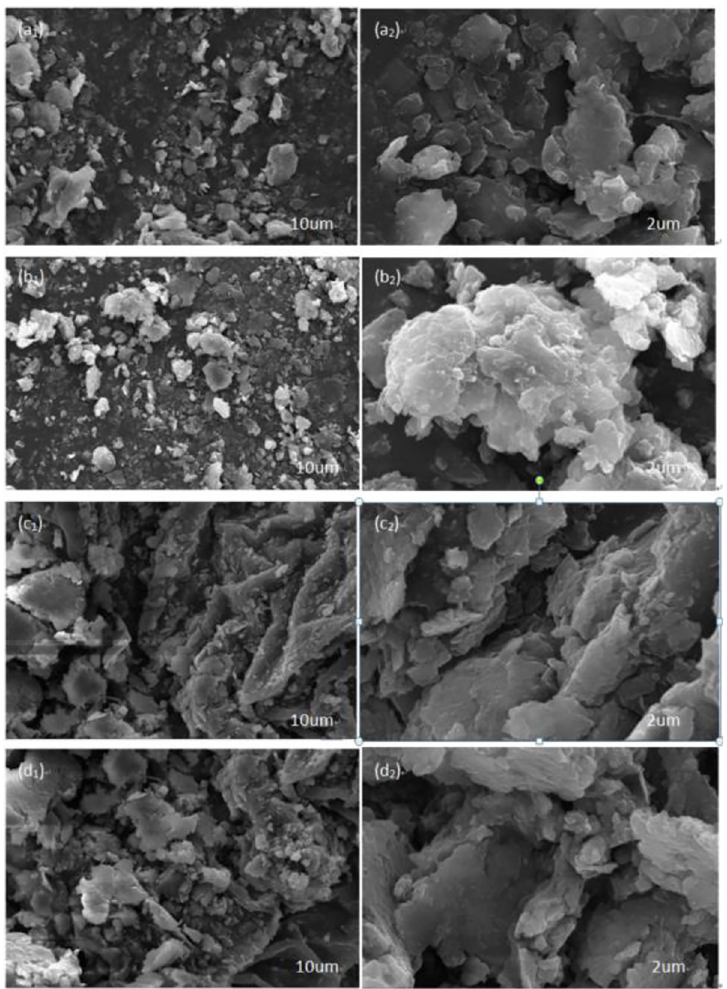
2 ); Natural dry oily sludge samples added to Cement (c 1 ,c 2 ); Natural dry oily sludge samples added to OSM (d 1 ,d 2